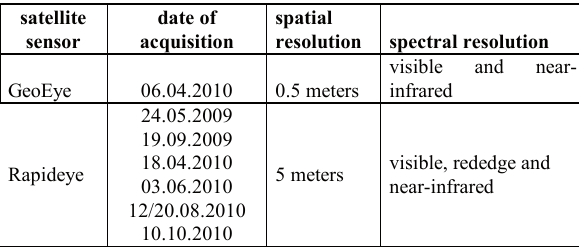
Table 2. Satellite data available for the two test